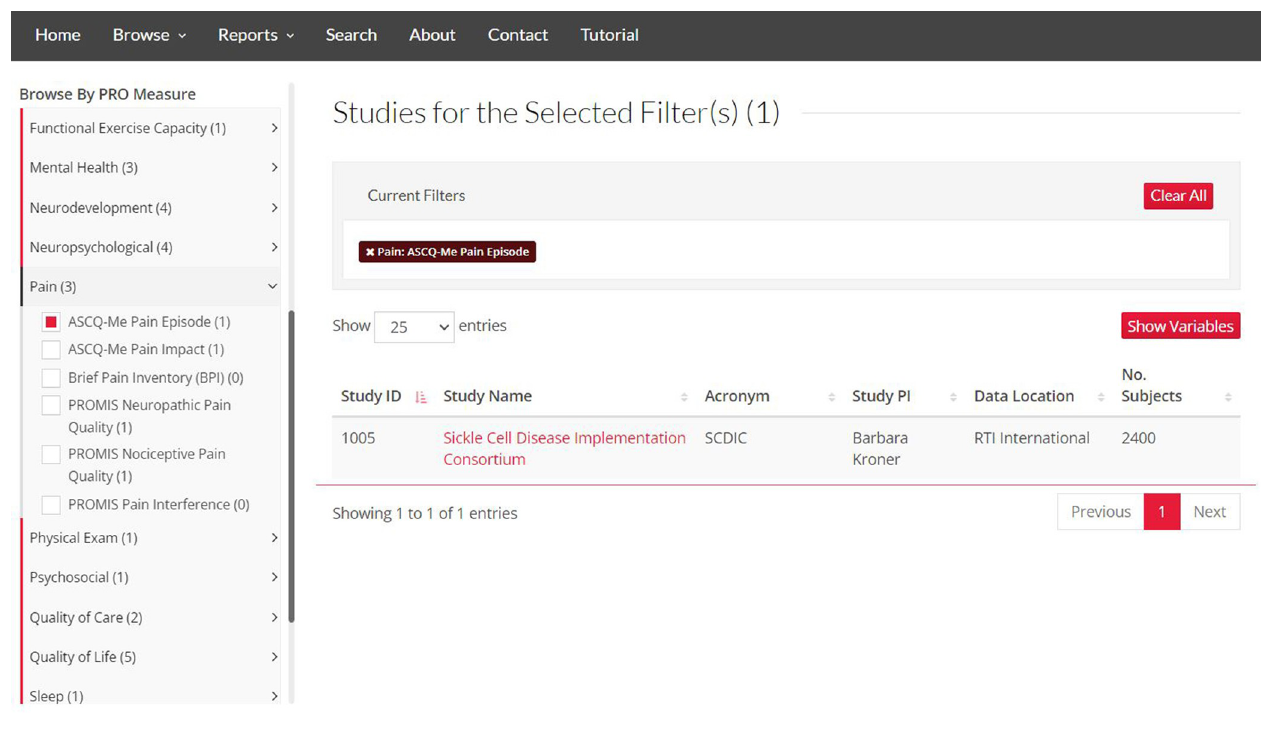
Fig 4. The “Browse Studies by PRO Measures” tool. This tool dynamically displays studies matching the selected PRO Measures. Republished from https:// curesicklecell.rti.org/ under a CC BY license, with permission from Public Library of Science (PLOS), original copyright 2022.